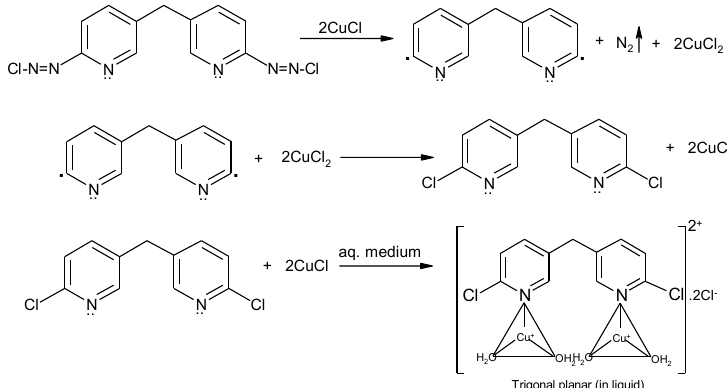
Figure 4. Probable